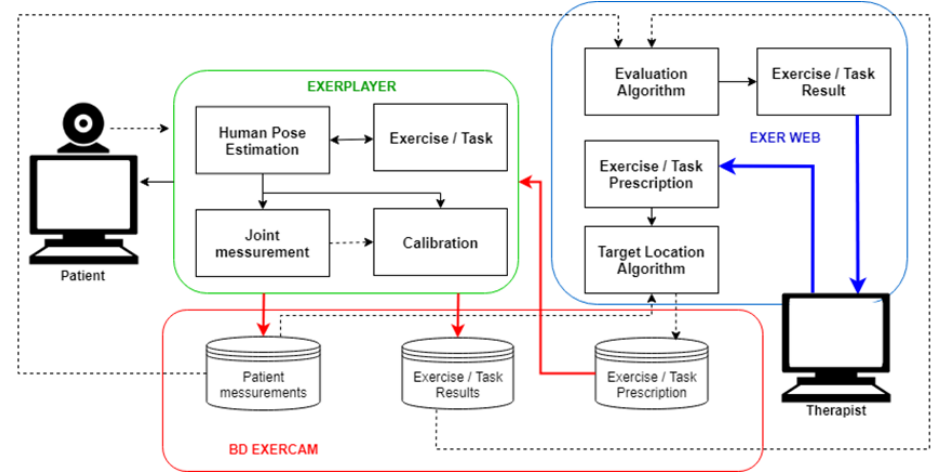
Figure 1. General architecture of ExerCam.